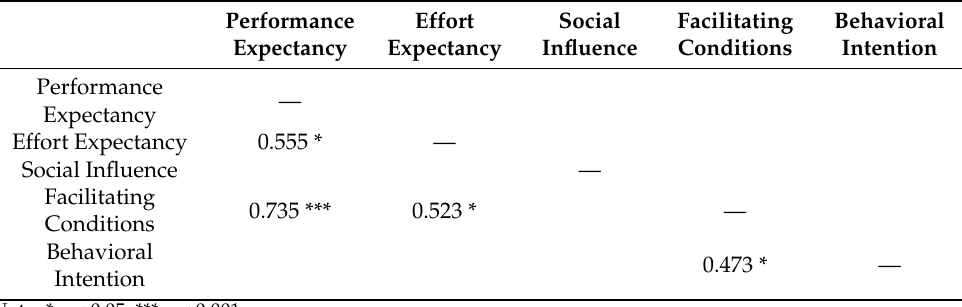
Table 4. Correlation Matrix UTAUT dimensions—SHERPAM project D0.